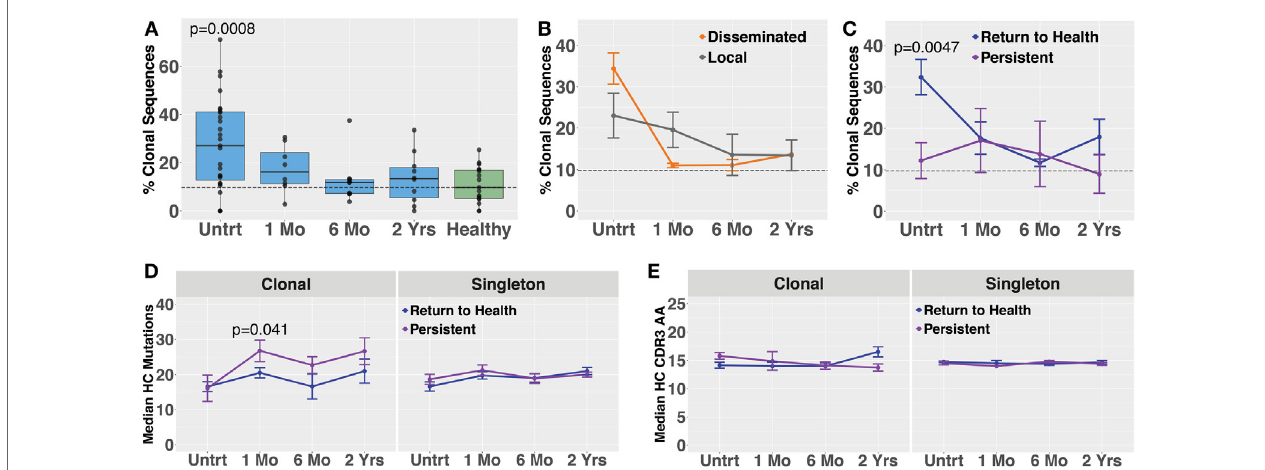
FigUre 4 | Paired-chain plasmablast repertoire sequence characteristics are similar to those observed in bulk B cell heavy-chain sequencing. Blood plasmablasts were single-cell sorted and tagged with cell-specific barcode oligonucleotides to enable sequencing of their paired heavy- and light-chain genes, yielding a mean of 436 full-length variable region paired sequences per subject. Plasmablasts were defined as CD19 int/ + CD3 − CD33 − CD14 − CD20 int/ − CD27 + CD38 hi live single cells. (a) Degree of clonal lineage expansion was significantly increased in plasmablasts from untreated Lyme disease. Percent clonality was calculated, across serial time points, as the percent of cells that were part of an expanded clonal family out of the total number of paired sequences from that time point. (B) Clonality showed a trend of increase in plasmablasts from patients with disseminated erythema migrans rash. (c) As was seen with bulk B cells, patients with a shorter duration of symptoms (return to health) exhibited significantly greater plasmablast clonality than those with persistent symptoms. (D) Mutations from germline and (e) CDR3 amino acid lengths showed minor variations among patient subsets. P values are ANOVA with Dunnett’s (a) or Sidak’s (B–e) multiple comparisons tests. Dashed lines represent the median value of healthy controls, and error bars represent